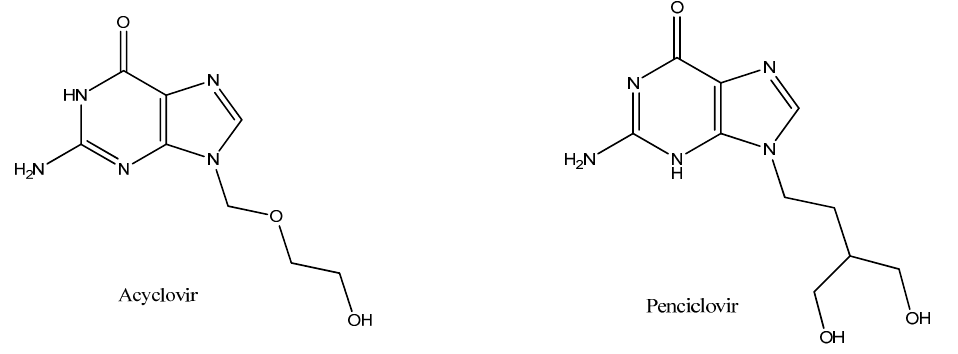
Figure 1. Chemical structures of acyclovir (ACV) and penciclovir (PNV).